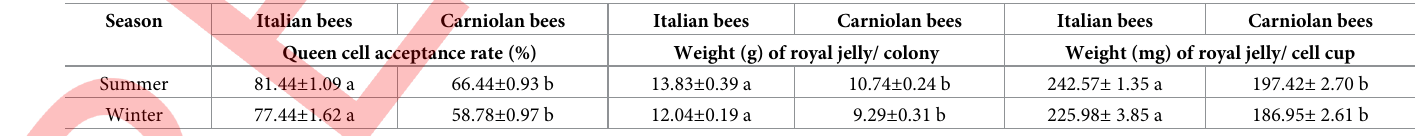
In the row, the small different letter shows the significant difference between them (Student’s t-test, p <